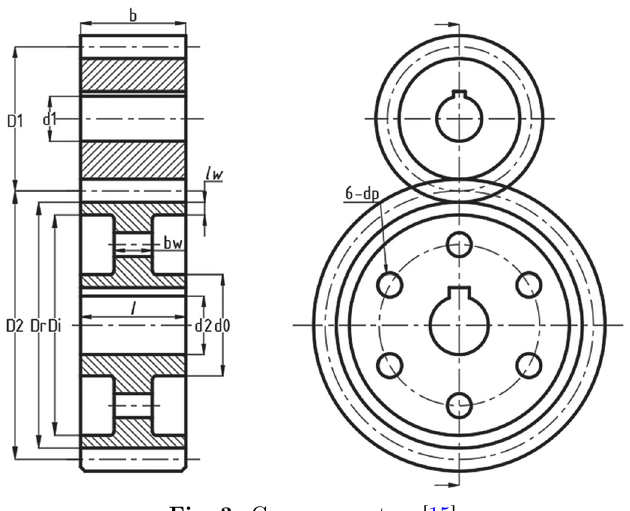
Fig. 3. Gear parameters